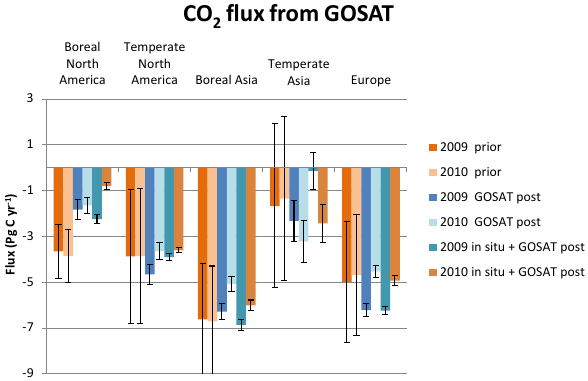
Figure 14. Comparison of prior, GOSAT only posterior, and in situ + GOSAT posterior fluxes aggregated over northern regions for June–July–August of 2010 vs. 2009. Included are NEP ( ×− 1) and fire fluxes. Error bars represent 1 σ uncertainties.